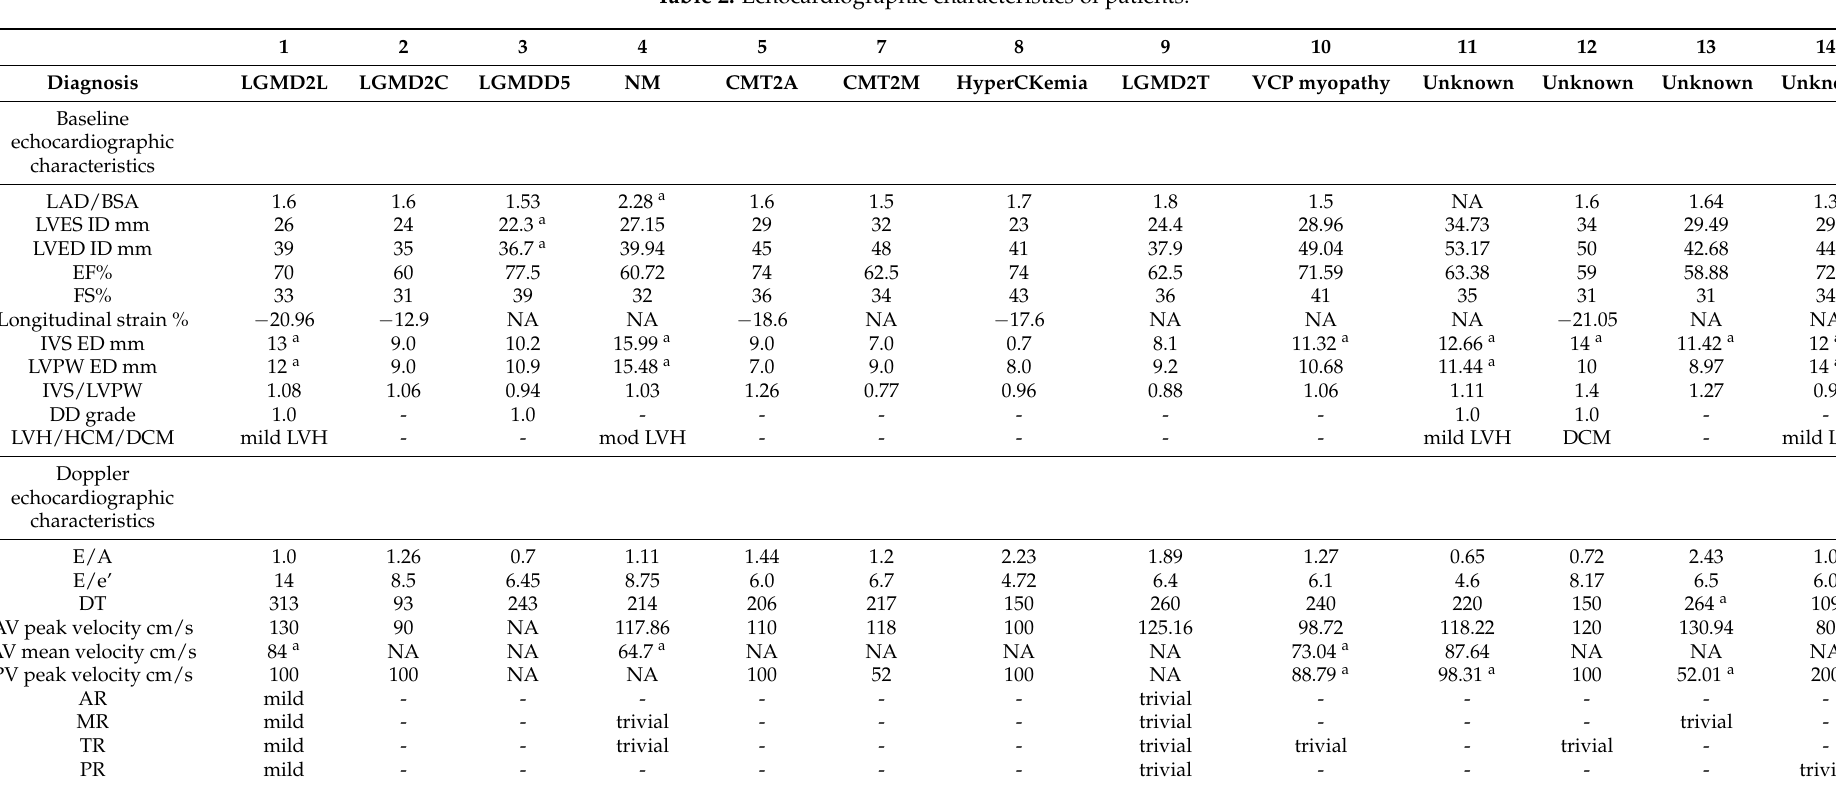
Table 2. Echocardiographic characteristics of